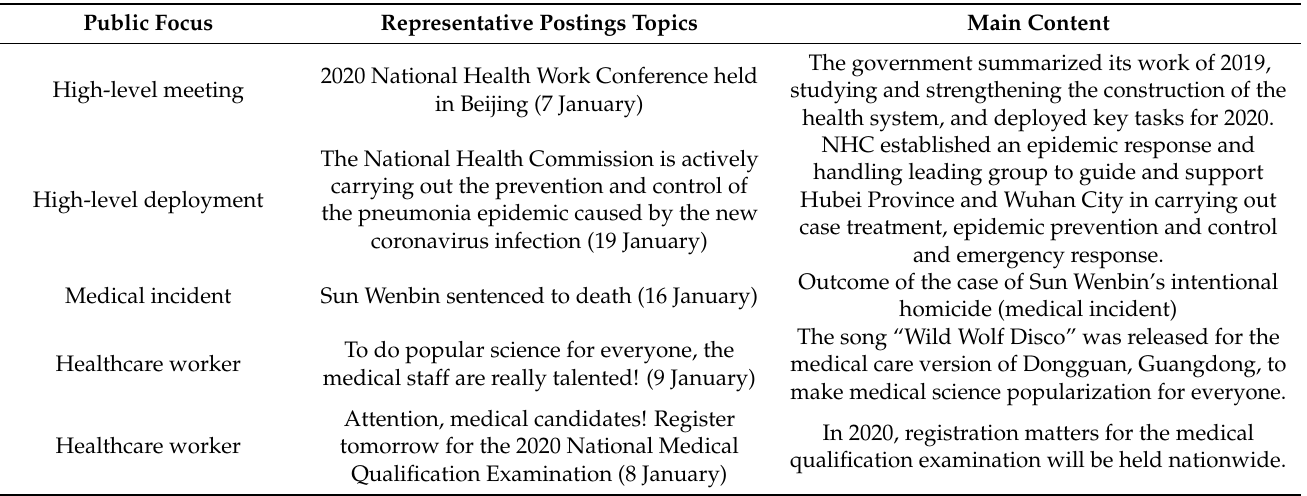
Figure 6. Keywords of co-occurrence network of government information supply in the incubation stage. Table 2. Postings with high public attention in the incubation stage (top